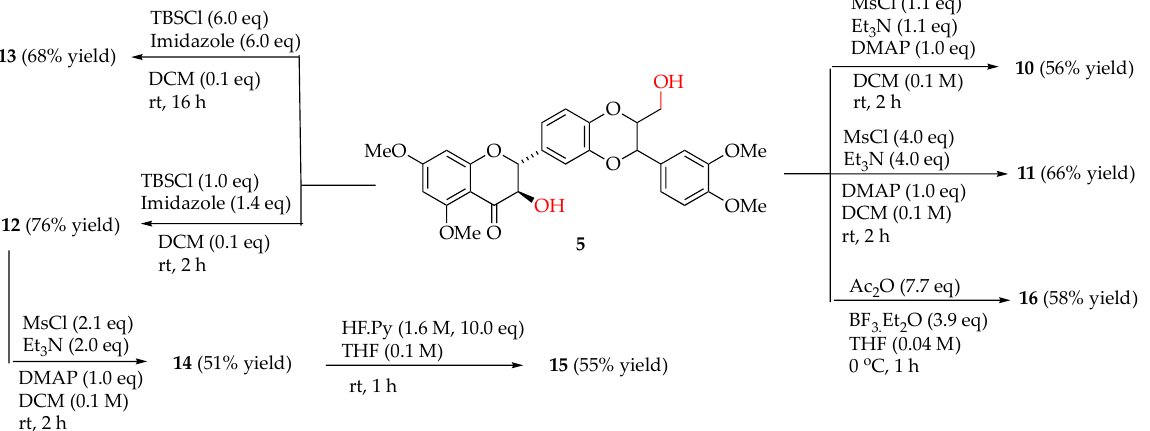
Scheme 1. Synthesis of 5,7,20- O -trimethylsilybins 10 – 16 . For chemical structures of 10 – 16 , refer to Figure 2. 2.2. Synthesis, Structural Characterization, and Antiproliferation Evaluation of 5,7,20-O-Trimethylhydnocarpin Ds 17 ‒ 22 Hydnocarpin D ( 2 , Figure 1) is a luteolin-subtype flavonolignan and was isolated from the flowering plant Hydnocarpus wightiana in extremely limited amounts as a racemic mixture devoid of optical activity [17,18]. The in vitro anti-prostate cancer potency of hydnocarpin D has only been evaluated in the AR-negative DU145 cell line with an IC 50 value of 4.9 µM [19]. No other anti-prostate cancer activity has been explored for hydnocarpin D or other luteolin-subtype flavonolignans. To compare the antiproliferative potency of 5,7,20- O -trimethylsilybins (taxifolin-subtype flavonolignans) with that of 5,7- O -trimethylhydnocarpin Ds (luetolin-subtype flavonolignans), 5,7,20- O -trimethylhydnocarbin-D ( 17 ) (Figure 3 and Scheme 2) was first synthesized from 5,7,20- O -trimethylsilybin ( 5 ) through a four-step transformation. To eliminate the secondary aliphatic 3-OH, the primary aliphatic 23-OH was first protected as TBS ether in 12 . A mesyl group was then incorporated into the 3-OH in 14 to yield a good leaving group by reacting with methanesulfonyl chloride (MsCl) mediated by triethylamine and DMAP. The elimination of 14 using sodium hydride as a base and HMPA as a solvent gave 23- O -TBS-5,7,20- trimethylhydnocarpin D ( 18 ). The removal of TBS afforded 5,7,20- O -trimethylhydnocarpin D ( 17 ), which was converted to its mesylate ( 19 ) and 23- O -(thio)carbamoyl derivatives ( 20–22 ) (Figure 3 and Scheme